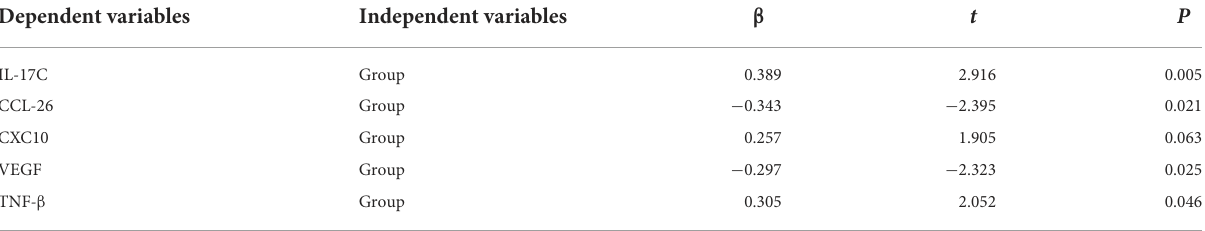
TABLE 3 Association between the group and the abnormal cytokines (multiple linear regression).